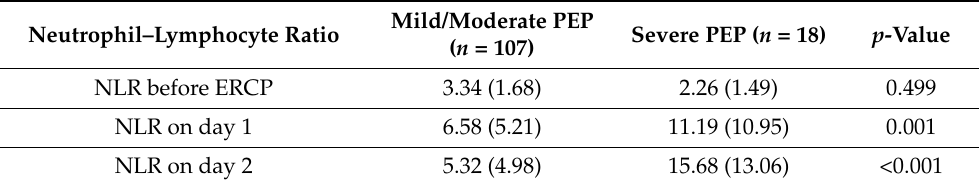
Table 2. Changes over time in the neutrophil–lymphocyte ratio in the mild/moderate and severe PEP groups.